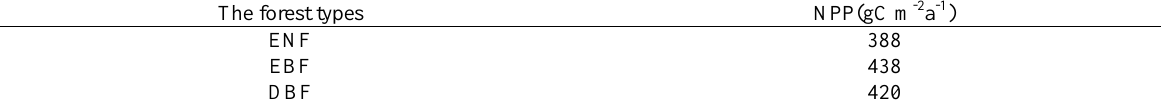
The forest types